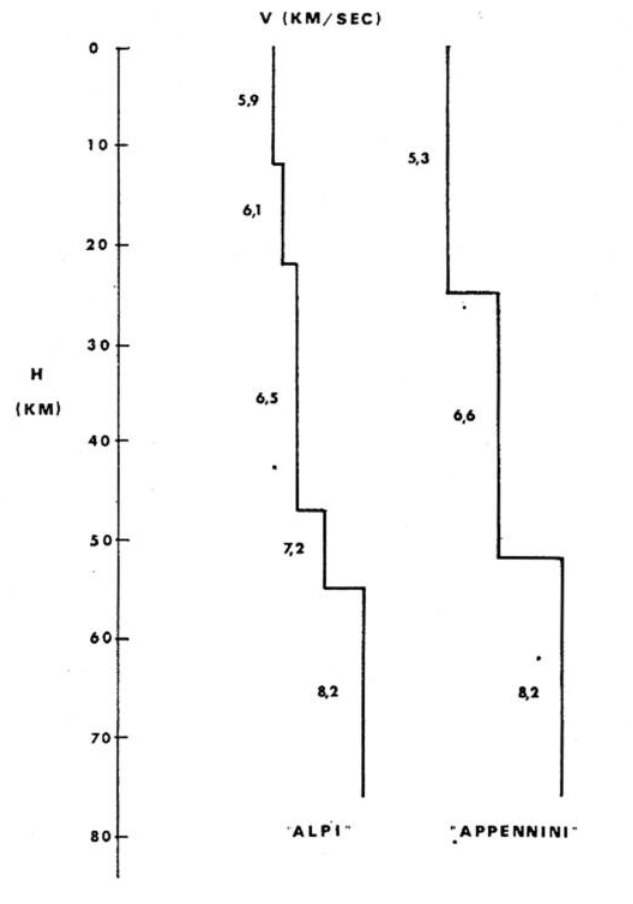
Figura 2. Modelli crostali delle dromocrone